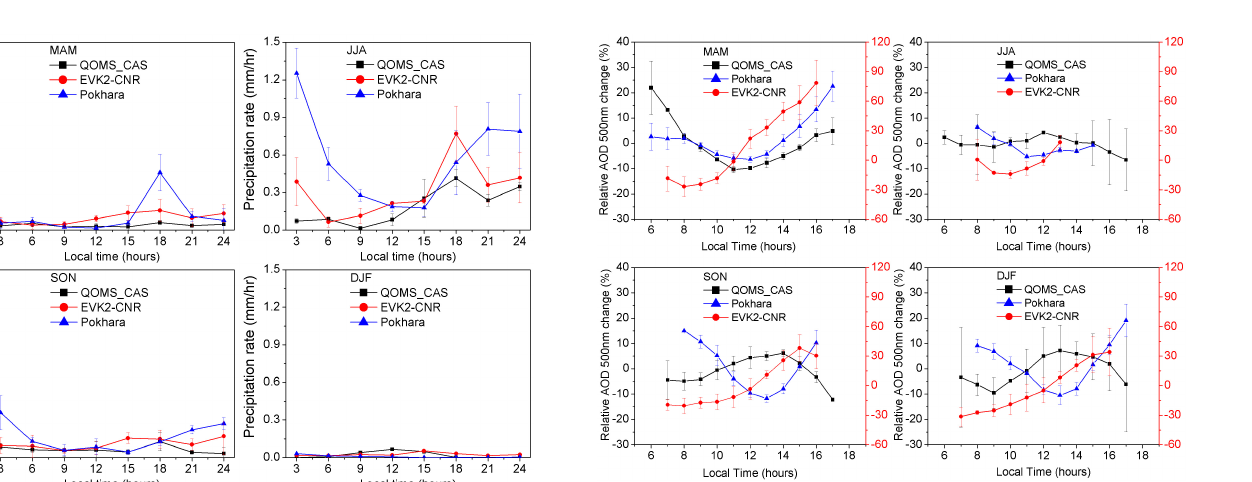
Fig. 8. Diurnal variations of PR at the three stations across all sea- sons. The error bars indicate the inter-annual difference of PR at each time. MAM denotes March to May, JJA denotes June to Au- gust, SON denotes September to November and DJF denotes De- cember to February in the next year (the following season divisions are the same).